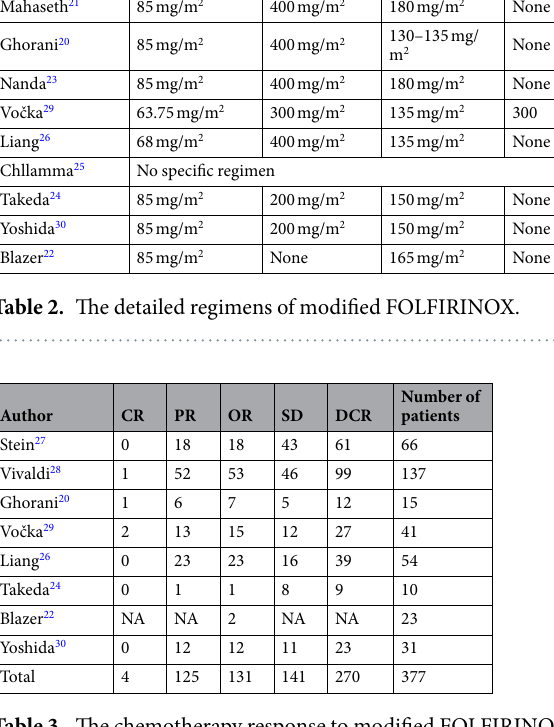
Table 3. The chemotherapy response to modified FOLFIRINOX. CR: complete response rate. PR: partial response rate. SD: stable disease rate. OR: overall response rate. DCR: disease control